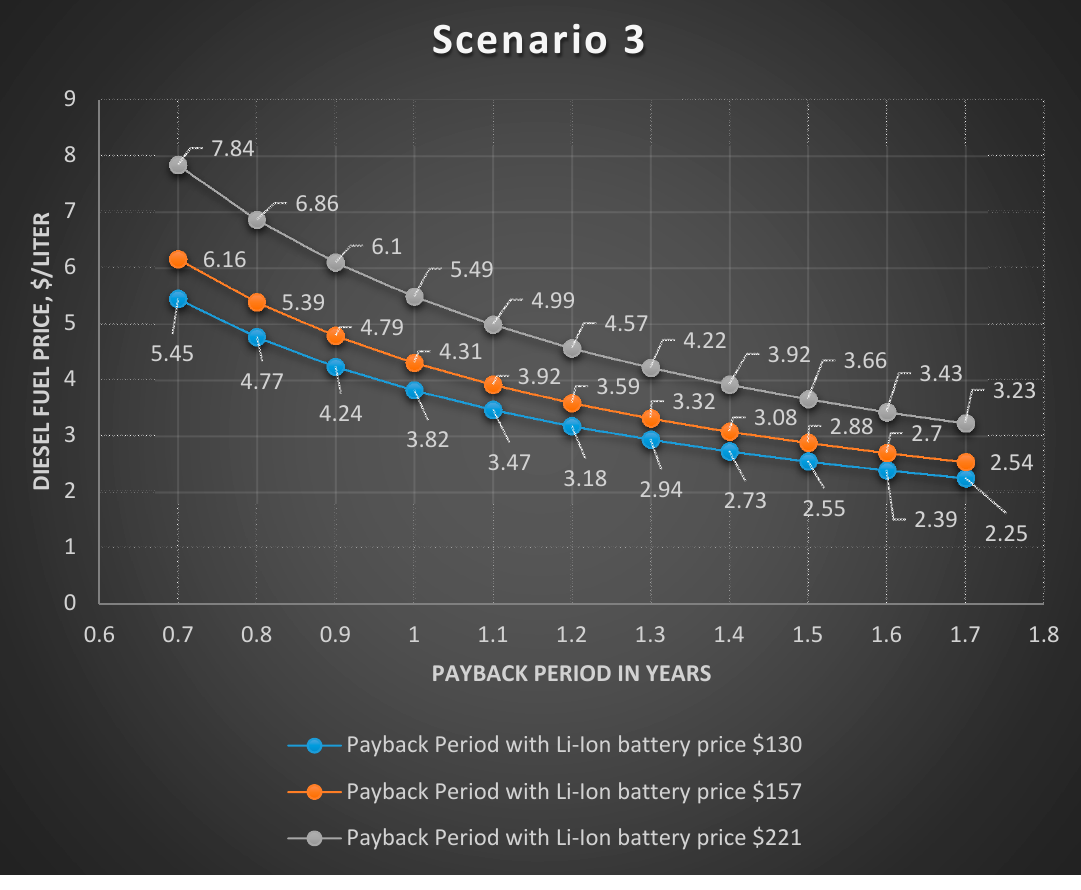
Figure 11. Payback years for different fuel prices.